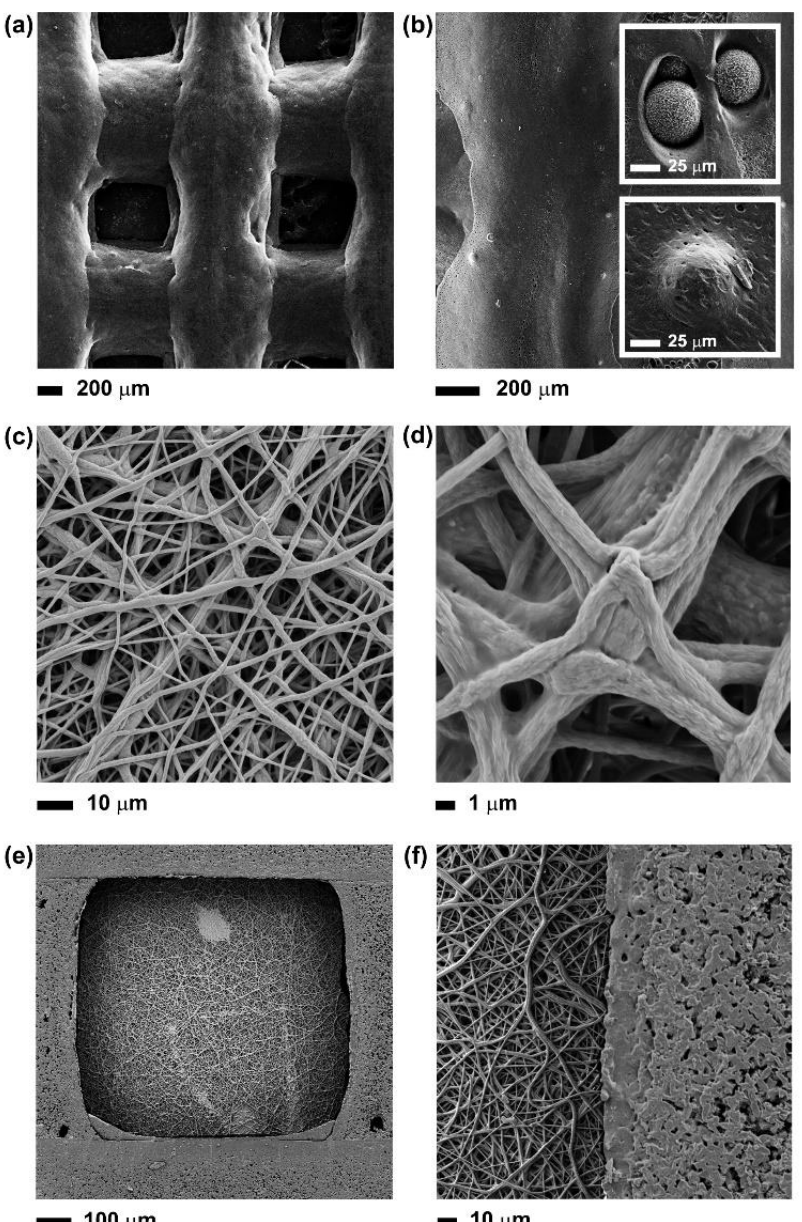
Figure 2. SEM images at different magnifications of: ( a ) and ( b ) the 3D-printed scaffolds, showing also the BG microspheres exposed onto the surface or embedded into the polymer matrix (insets); ( c ) and ( d ) the surface of the composite scaffold covered with a layer of electrospun PCL–PGS mats, pointing out the fusion between fibres; ( e ) and ( f ) the surface of the composite scaffold without the layer of electrospun fibres.